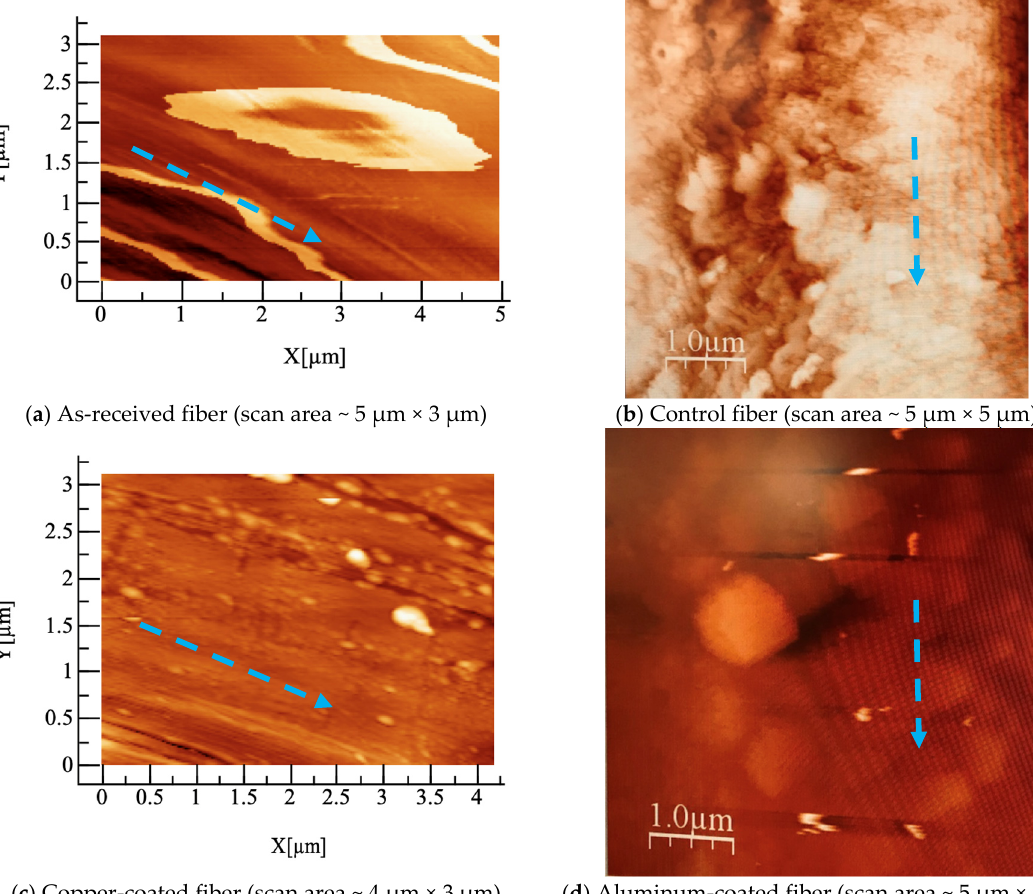
Figure 15. Atomic ‐ Force Microscopy (AFM) images of As ‐ received and metal ‐ coated single fibers with fiber directions indicated by arrows ( a ) As ‐ received S706 fiber phase image showing variable energy dissipation, presumably due to the sizing ( b ) Control fiber topography ( c ) Copper ‐ coated fiber topography ( d ) Aluminum ‐ coated fiber topography.